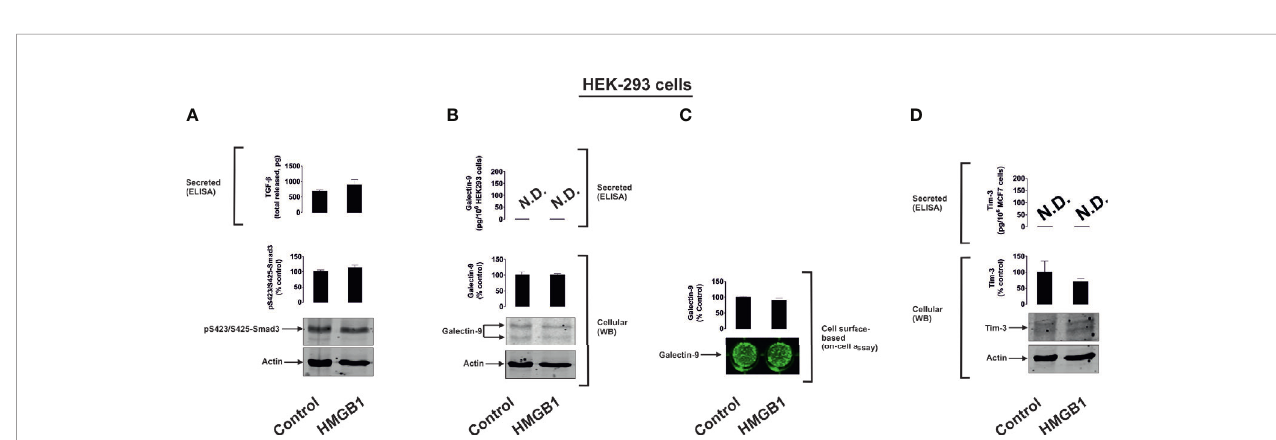
FIGURE 4 | The effects of HMGB1 on Galectin-9 and Tim-3 expression in MCF-7 human breast cancer cells. MCF-7 cells were exposed for 24 h to 1 µg/ml HMGB1 followed by measurement of TGF- b secretion and Smad3 activating phosphorylation (A) , galectin-9 protein expression and secretion (B) , galectin-9 cell surface presence (C) and Tim-3 protein expression and release (D) . Images are from one experiment representative of four which gave similar results. Quantitative data are shown as mean values ± SEM of four independent experiments.